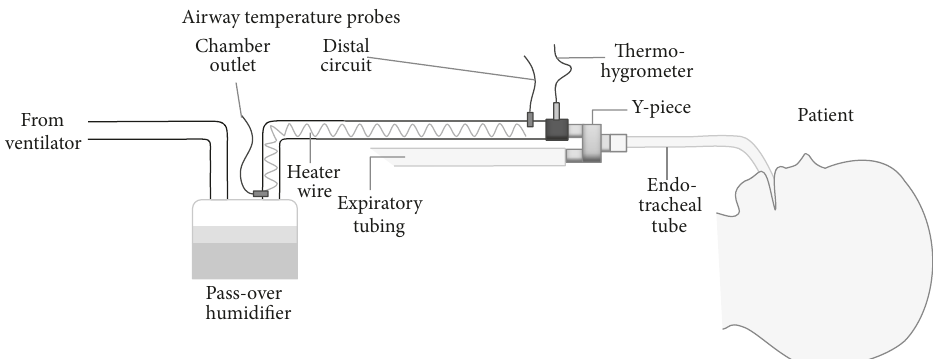
Figure 1: Configuration of the ventilator circuit. A thermohygrometer was inserted between the distal end of the heated inspiratory circuit and the Y-piece. Nonheated extension tubes were not used in the current study cohort.